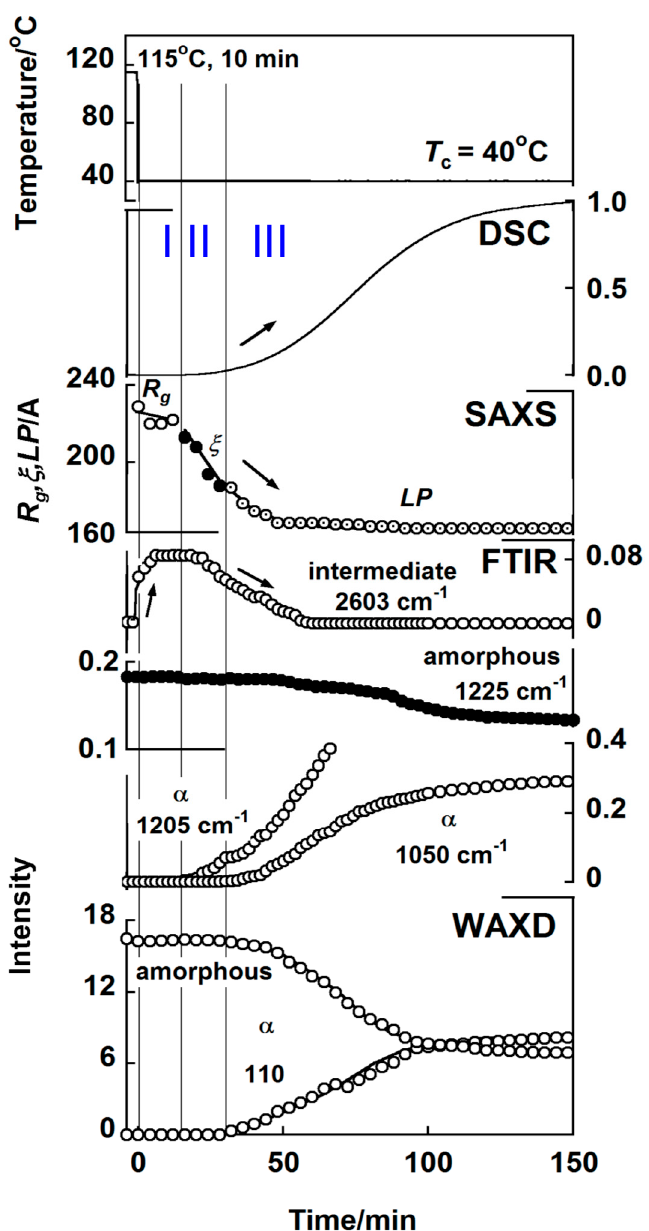
Figure 8. Time dependence of the various structural parameters collected for trans-1,4-polyisoprene in the isothermal crystallization from the melt. The intermediate phase started to appear immediately after the temperature jump and existed for a while until the crystalline α phase was created and increased its amount [36].